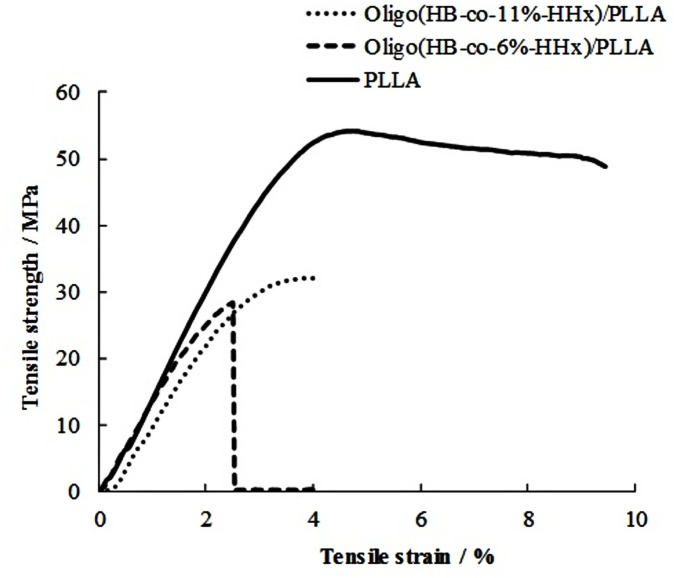
Stress-strain curves for neat PLLA and oligo(HBHHx)/PLLA blends.